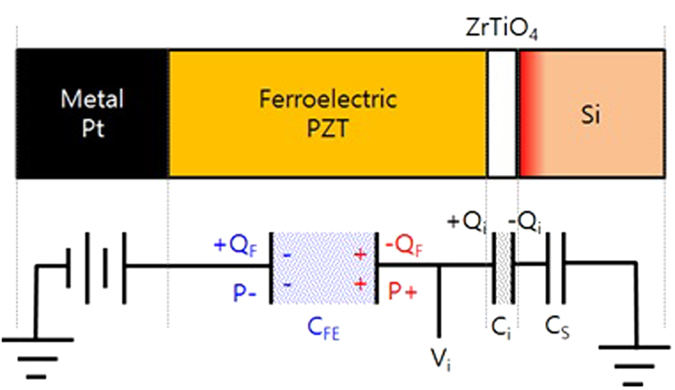
Multi-stacked gate oxide of SNLC-PZT FeFET is modeled by a ferroelectric capacitance (CFE) in series with the ZrTiO4 (Ci) and Si (CS) capacitance.